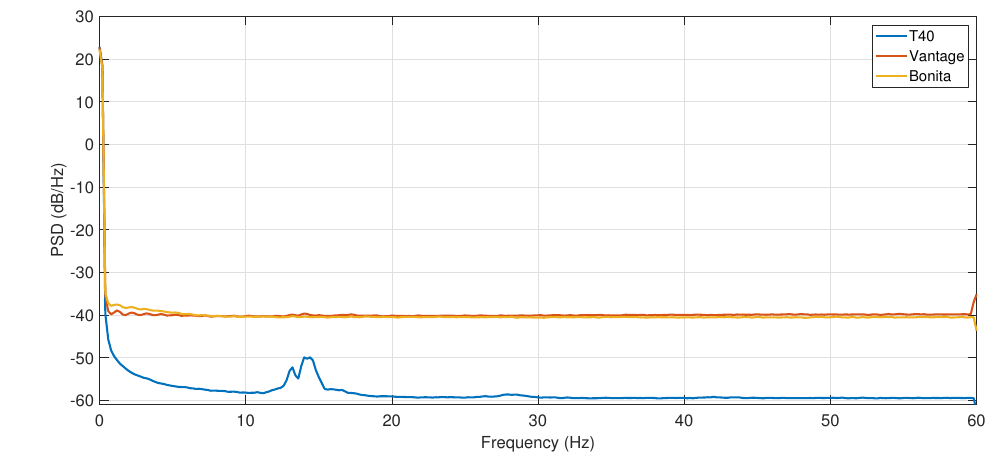
Figure 16. Distribution of correlated noises q c versus T c .